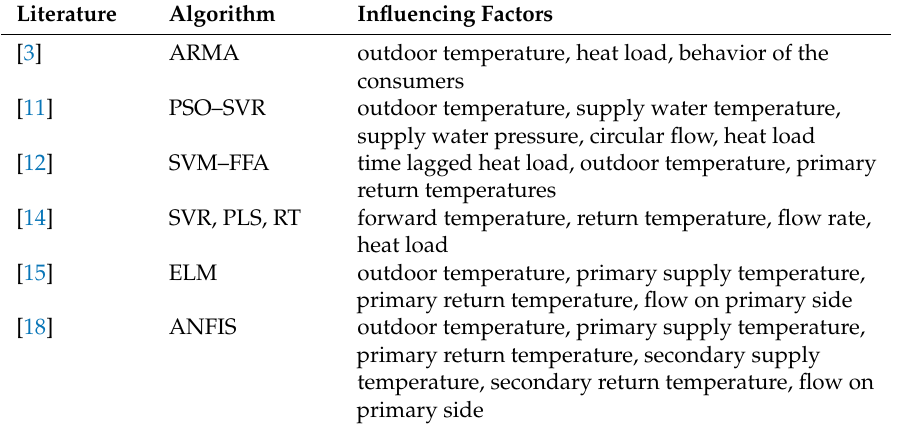
Table 1. The input factors to heating load prediction for the related